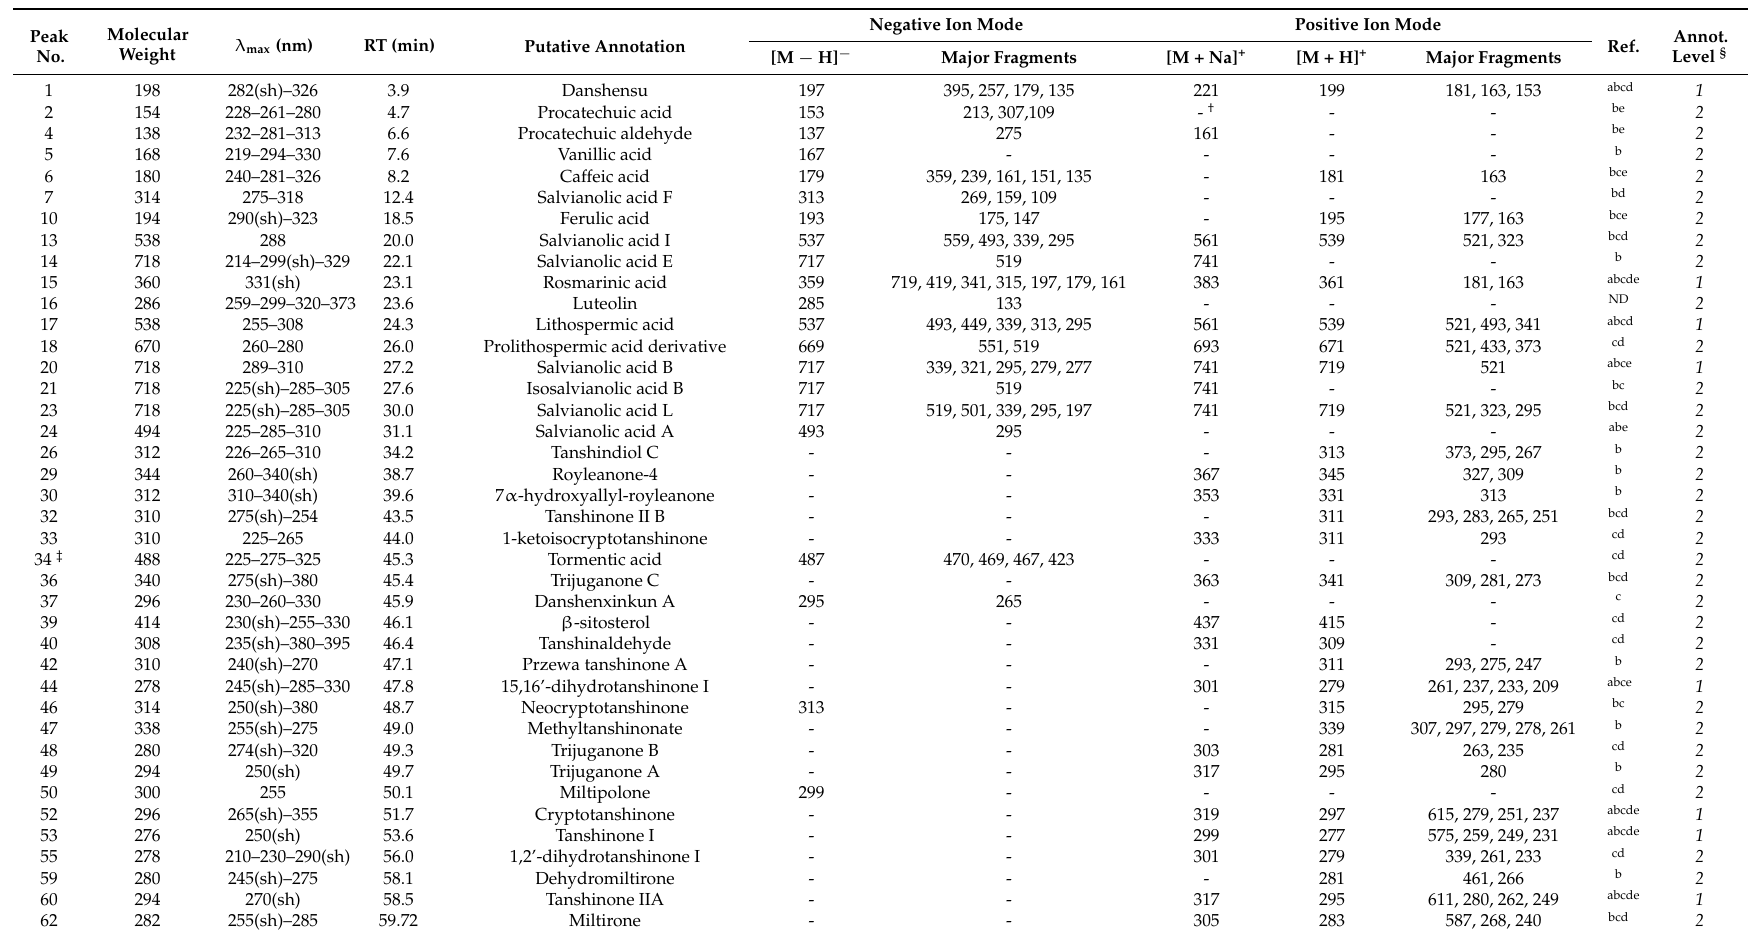
Table 1. Annotated compounds in S. miltiorrhiza samples based on literature